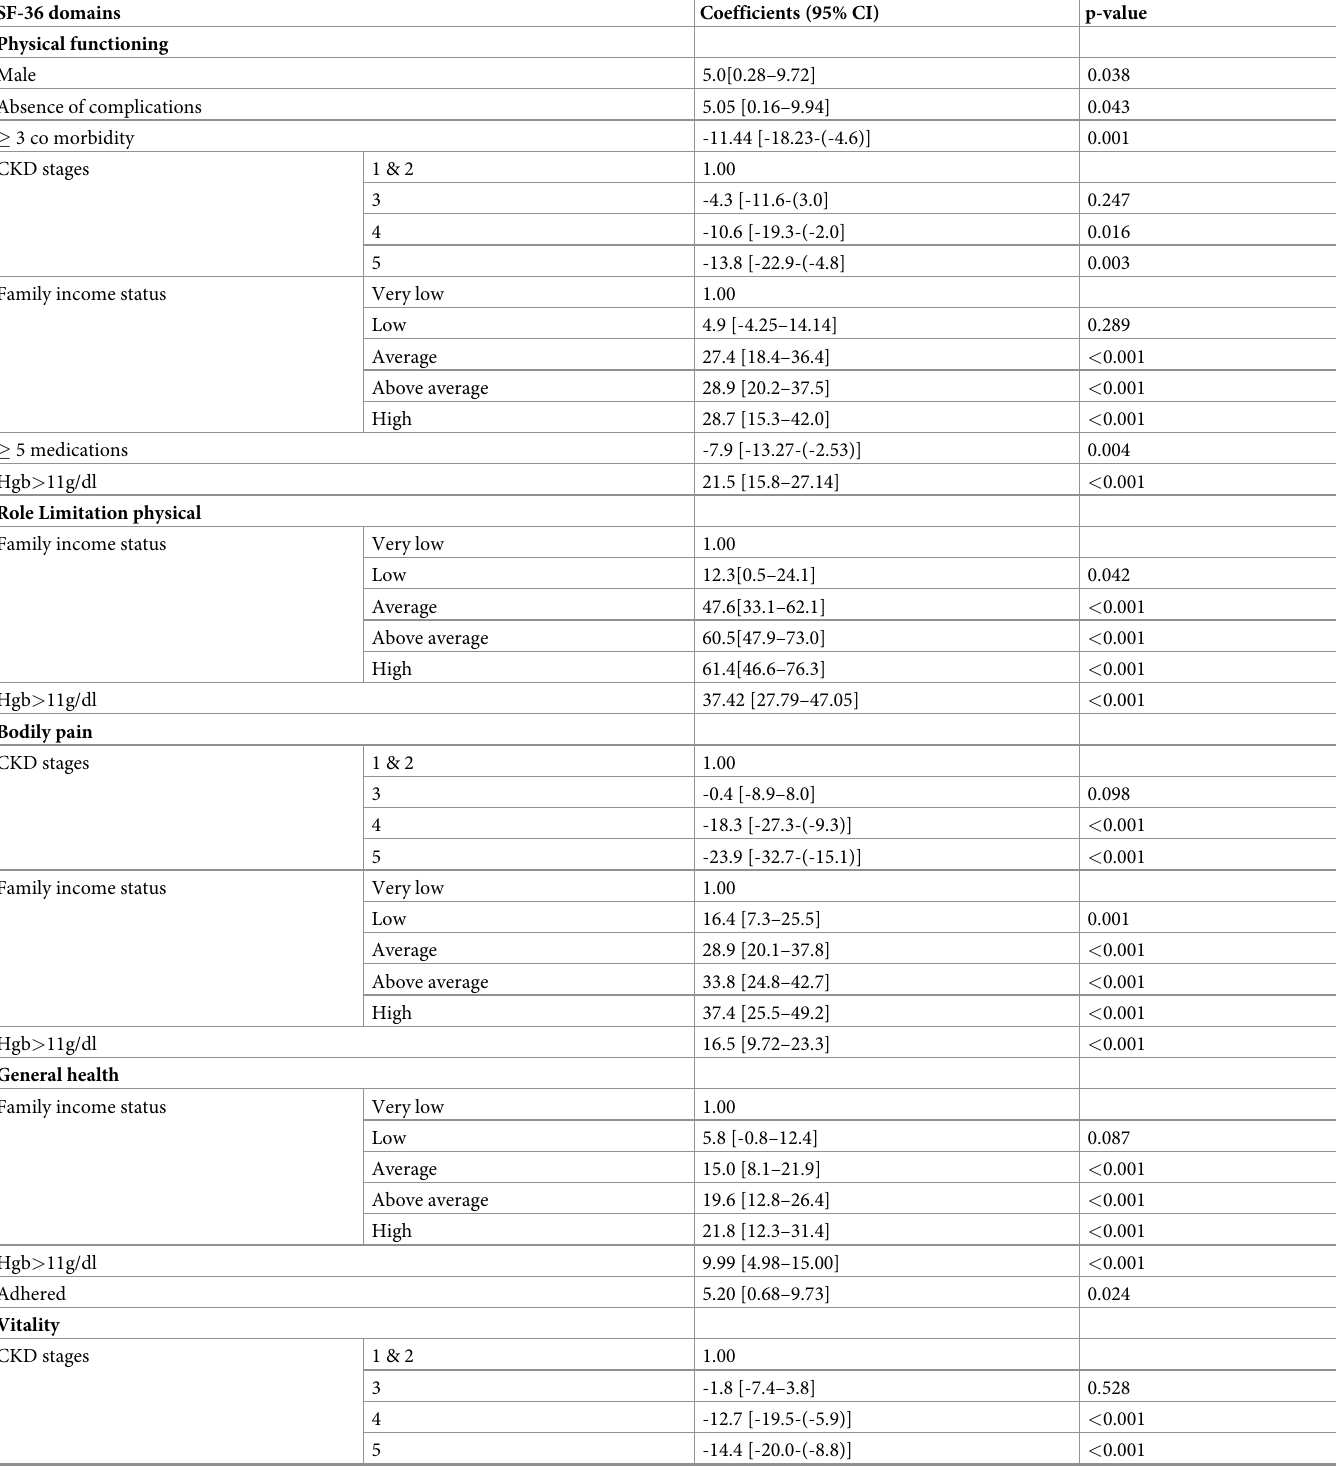
Table 8. Adjusted analysis for predictors of SF-36 domains among chronic kidney disease